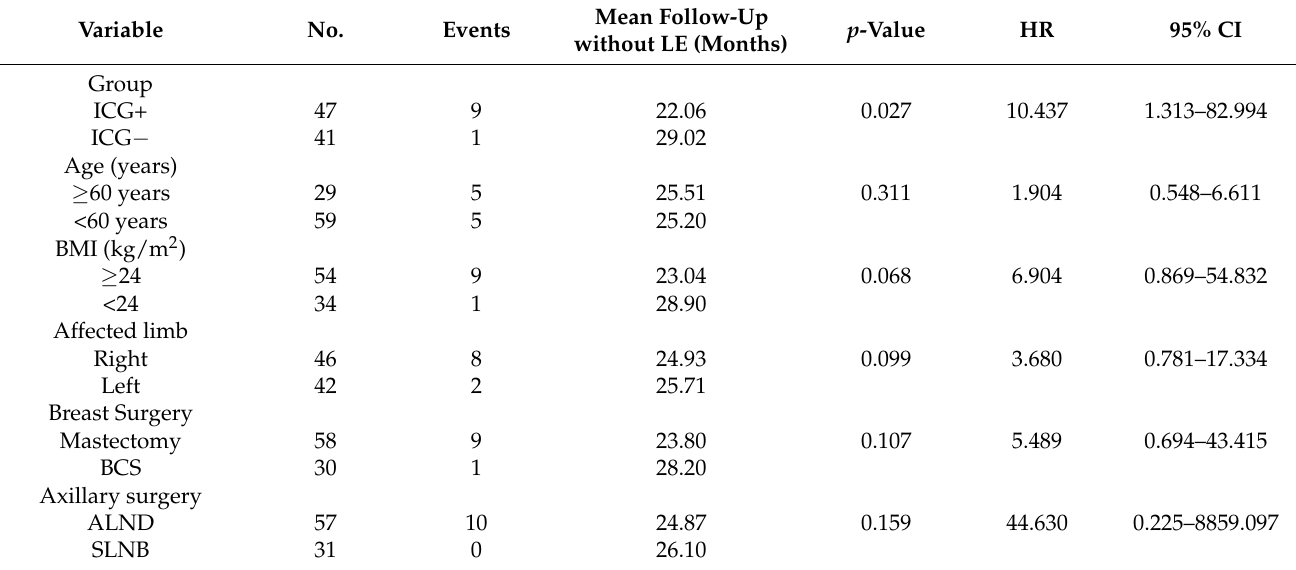
Table 3. Univariable COX regression of the risk factors affecting